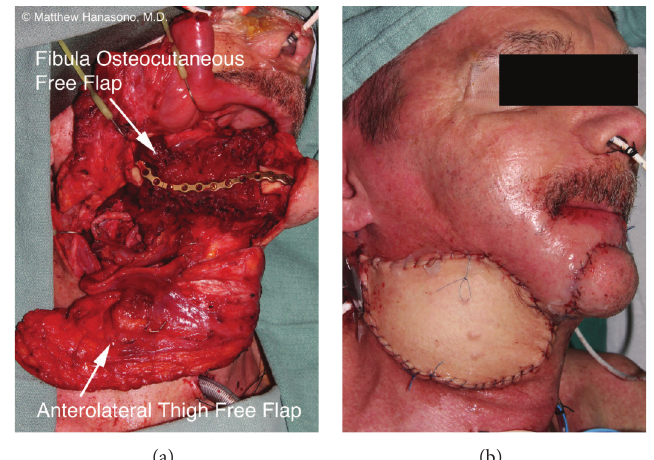
Figure 7: A fibula osteocutaneous free flap for mandibular and intraoral reconstruction and an anterolateral thigh free flap for external neck skin reconstruction (a). Completed reconstruction